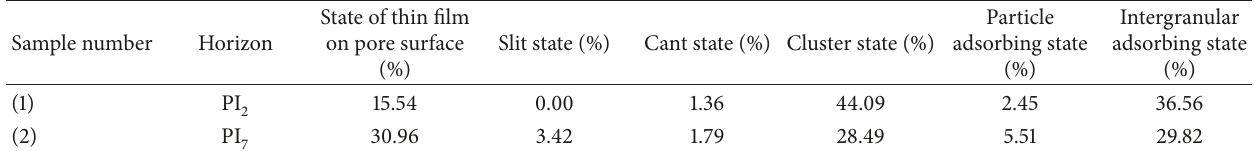
Table 4: Types and relative contents of the microscopic remaining oil.